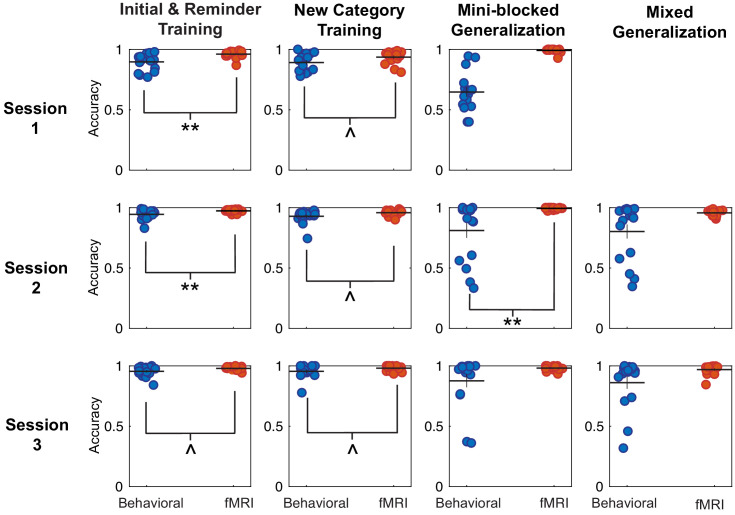
Accuracy in all sessions of the experiment for behavioral and fMRI groups.No statistical comparison between groups was made in the mini-blocked generalization phase of session 1 as accuracy in this phase was used to define these groups. Each point represents a single participant, horizontal bars represent the group mean and vertical bars indicate the standard error of the mean. **p<0.01, *p<0.05, ^p<0.1, Wilcoxon rank sum tests between groups.